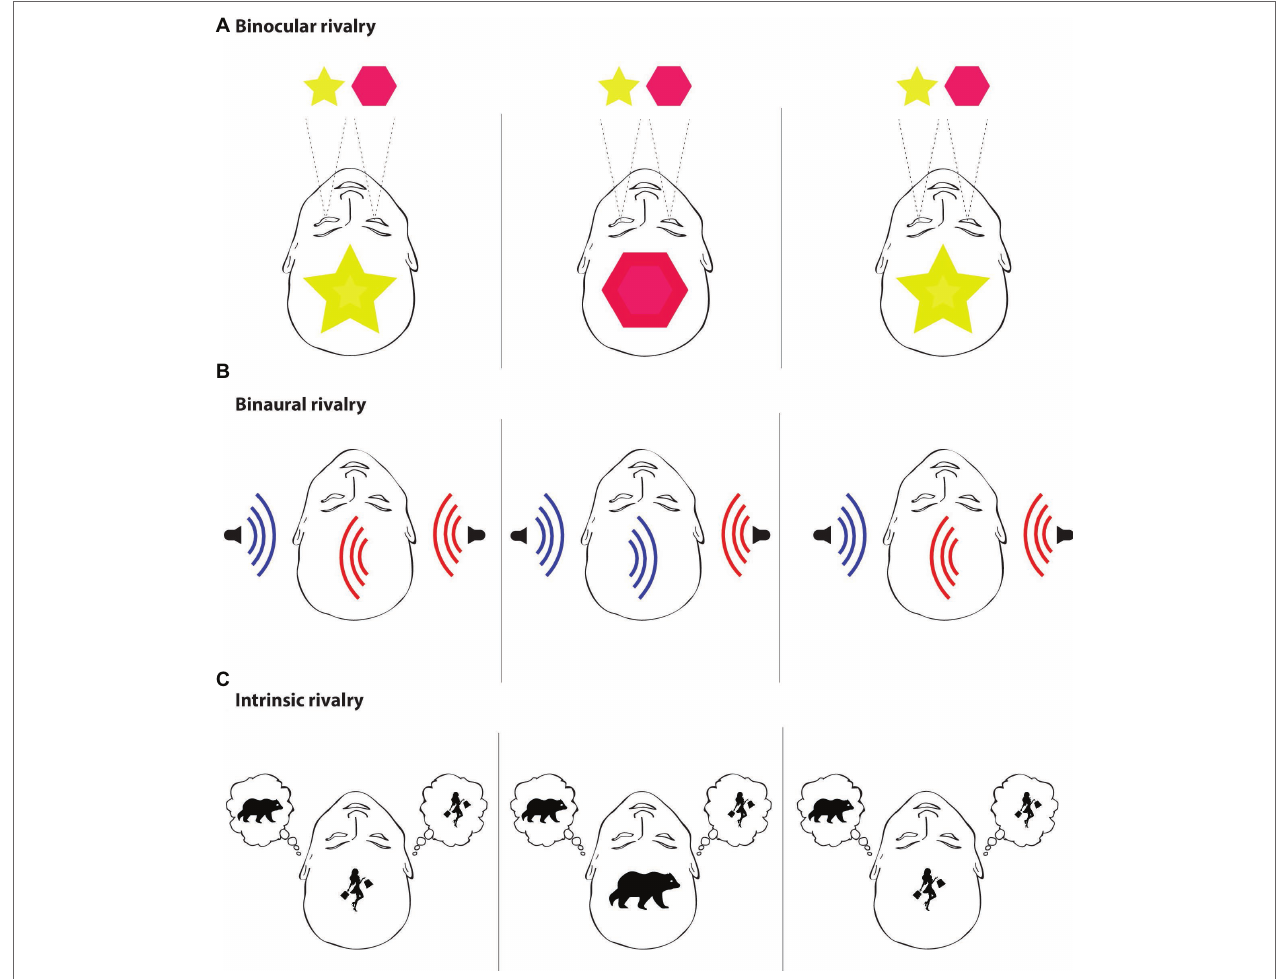
FIGURE 3 | Rivalry. Rivalry paradigms are based on the limited capacity of neural processing. Put simply, two different mental phenomena cannot occur in the stream of consciousness at the same time. In experiments, two different stimuli are usually presented but only one of them becomes conscious. (A) Binocular rivalry is a visual paradigm in which two different visual patterns (e.g., a star and a diamond, a face and a house, etc.) are presented to each eye separately. The two images are not merged together and cannot be consciously perceived at the same time; therefore, conscious experience spontaneously fluctuates between the two images despite the constant and unchanging visual input. (B) Binaural rivalry is an auditory paradigm in which two different auditory stimuli are presented to each ear separately by a set of headphones and only one of them enters the stream of consciousness. The conditions guaranteeing the competition of the two auditory stimuli are known as the dichotic listening task, which is used for understanding hemispheric asymmetries (Brancucci et al., 2005). (C) Intrinsic rivalry is a possible paradigm aimed at intrinsic mental phenomena that occur during resting states. This paradigm is based on intrusive thoughts, such as the “white bear,” which constantly enter the stream of consciousness and render previously experienced content, such as thinking about “shopping,” unconscious. The paradigm of intrinsic rivalry is in a way similar to the rivalry conditions used in studies aimed at perceptual domains of consciousness, with the only difference that there is rivalry between two intrinsic mental states and not between two perceptual states. However, even in the case of intrinsic mental phenomena, two different mental states still cannot occur in the stream of consciousness at the same time. Therefore, intrusive thoughts can be used in future studies of consciousness as a paradigm aimed at neural correlates of intrinsic mental phenomena and may be quite useful for answering the question, “Under what neural conditions can intrinsic mental states become